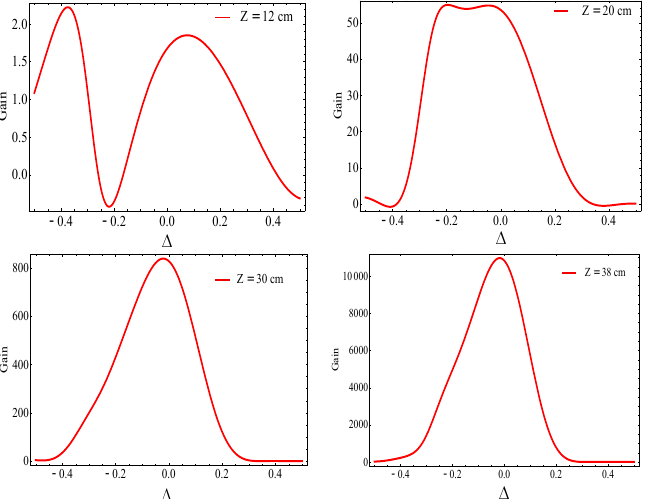
Figure 11. Gain vs. the normalized detuning ∆ at different z-position for the ω + resonance calculated using the analytical solution in the SSA regime with the parameters reported in Table 1.